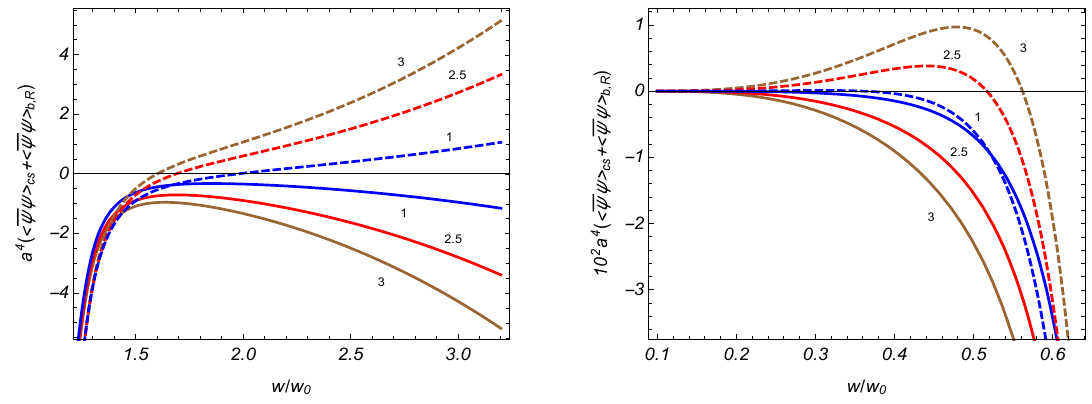
Figure 2 . The FC induced by the cosmic string and the brane versus the ratio w/w 0 for different val- ues of the parameter q (numbers near the curves). The full and dashed curves correspond to s = +1 and s = 1, respectively. For the other parameters we have taken ma = 1, r/w = 0 . 25 and α 0 = 0 . 3. − Note that for points near the brane one has The leading term is written as